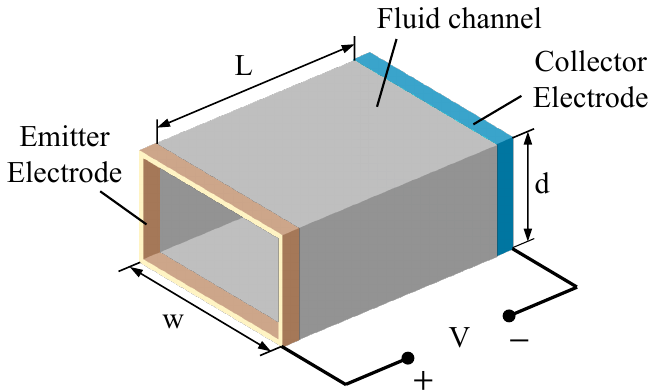
Figure 1. Fluid EHD pump geometry [7]. L , d and w represent channel length, depth and width, respectively. V denotes the high-voltage power